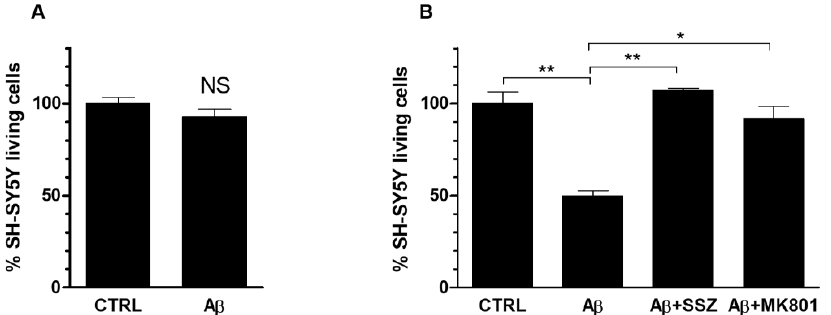
Figure 7. Role of System X c − and NMDA receptor activation on the viability of A β -treated SH-SY5Y differentiated cells. ( A ) SH-SY5Y cells were grown in mono-cultures and treated for 24 h with A β 25-35 (50 µ M). ( B ) SH-SY5Y cells were co-cultured with U373 cells and treated for 24 h with A β 25-35 (50 µ M) alone or in the presence of either SSZ (300 µ M) or MK801 (10 µ M). MTT cell viability assay was carried out as specified in Materials and Methods. The histograms show the percentage of living cells, and the rate of reduction was calculated by setting the control (CTRL) equal to 100%. Values are the means ± SEM from three separate experiments, each performed in duplicate. One-way ANOVA, followed by Bonferroni’s test, was used to determine significant differences. NS not significant; ** p ≤ 0.01 between CTRL and A β 25-35 ; ** p ≤ 0.01 between A β 25-35 and A β 25-35 + SSZ; * p ≤ 0.05 between A β 25-35 and A β 25-35 + MK801.